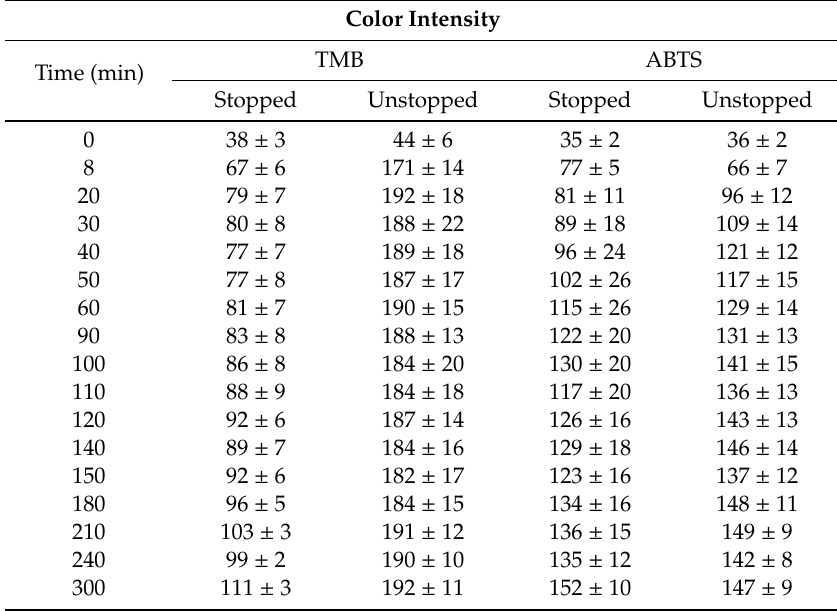
Table 2. Color intensity analysis for stopped vs. unstopped colorimetric signal stability over time. Color